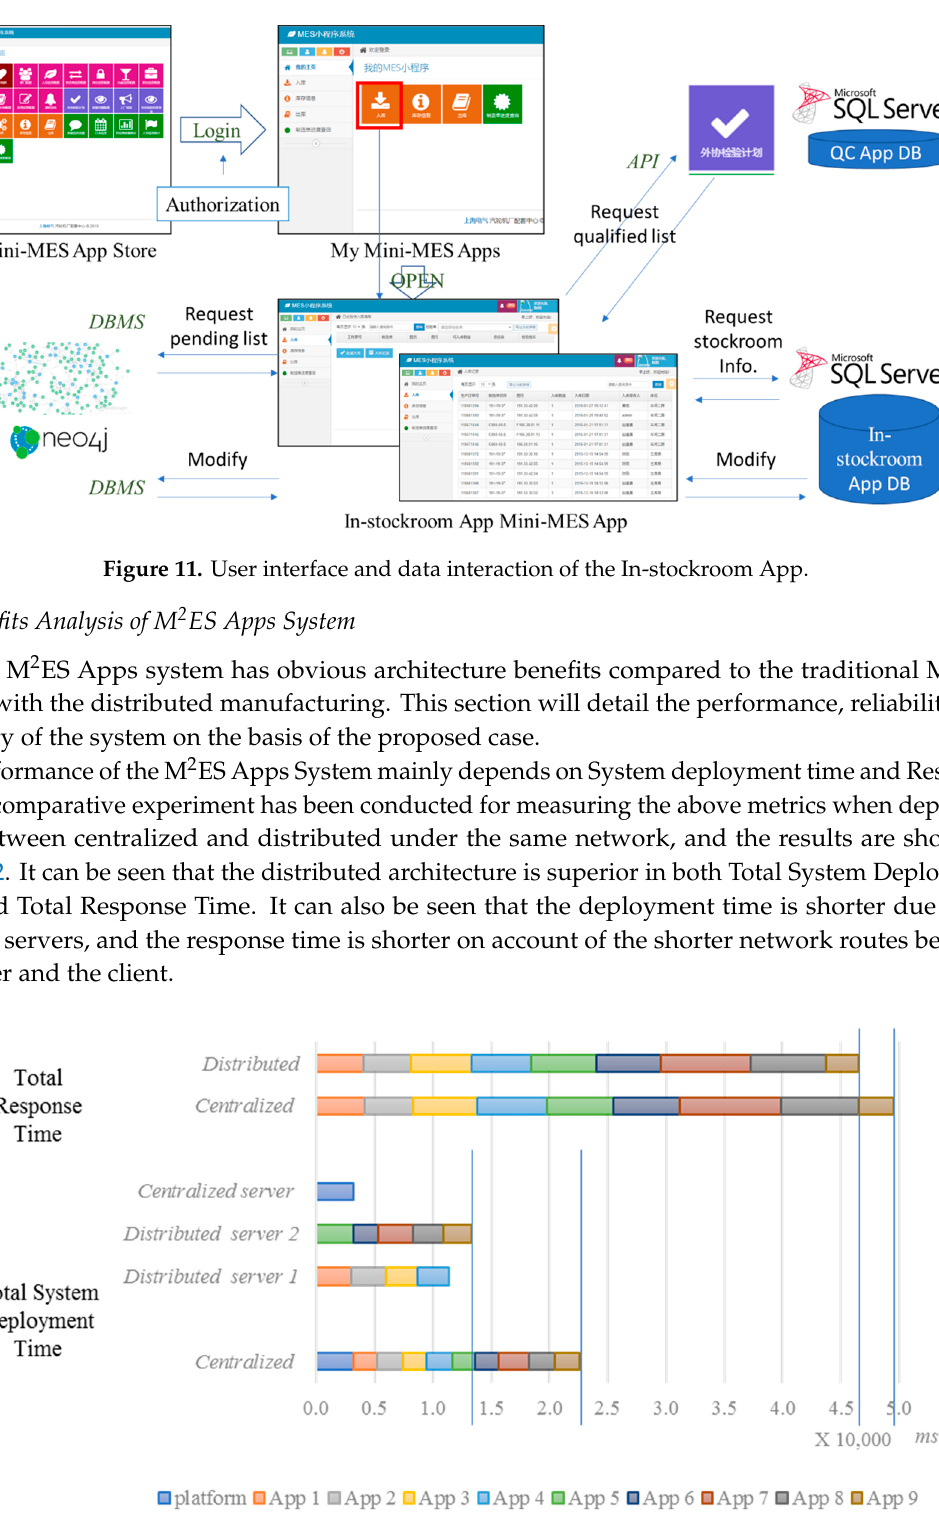
Figure 12. Experimental results on comparison of different architectures.